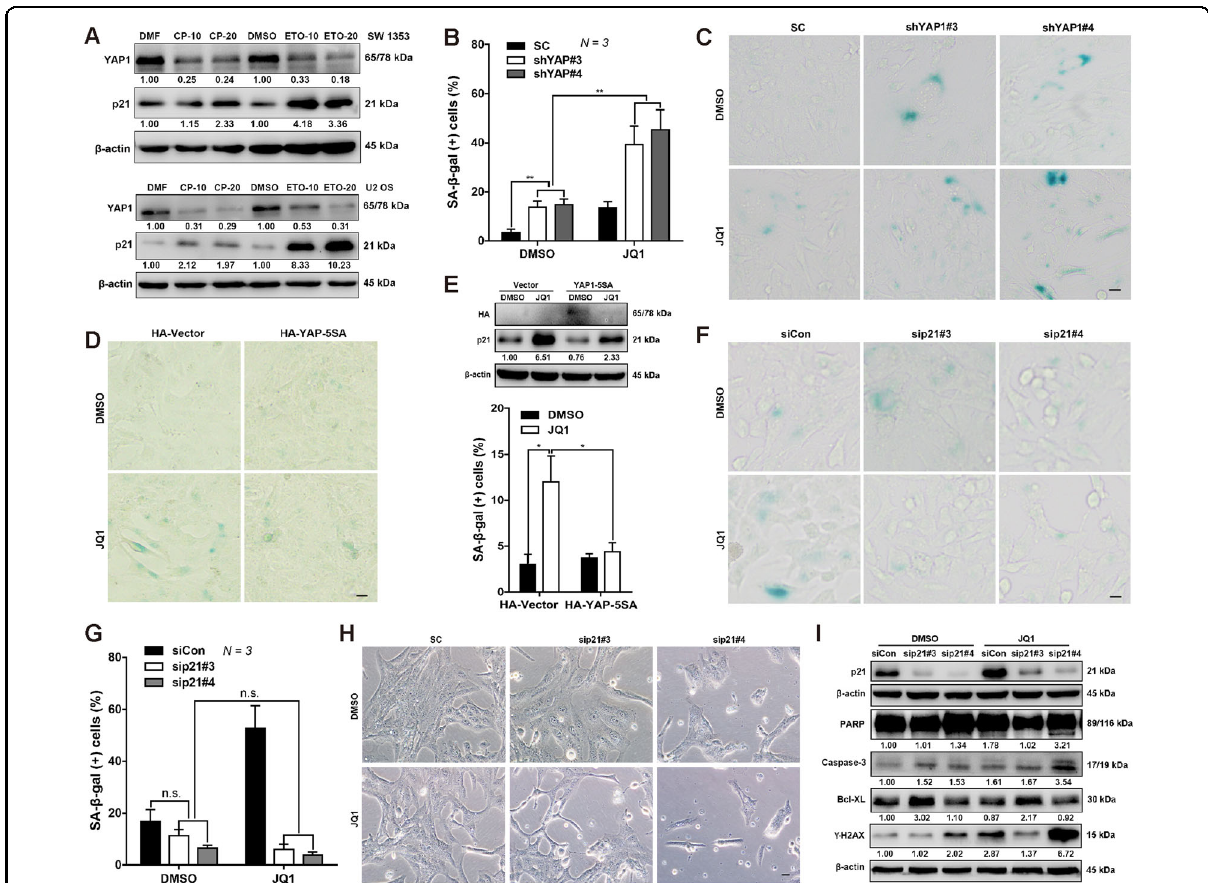
Fig. 6 The YAP1/p21 signaling axis is involved in chemotherapy-mediated cell senescence regulation. A SW 1353 and U2 OS cells were treated with dimethylformamide (DMF), cisplatin (CP; CP-10: 10 μ M, CP-20: 20 μ M), dimethyl sulfoxide (DMSO), and etoposide (ETO; ETO-10: 10 μ M, ETO-20: 20 μ M) for 24 h, and YAP and p21 expression was determined by IB. B , C YAP1 depletion enhances JQ1-induced senescence. Control shRNA or YAP1-depleted SW 1353 cells were treated with DMSO or JQ1 for 24 h, senescent cells were stained with SA- β -gal and quanti fi ed ( B ), and representative images are shown ( C ). Scale bars: 20 μ m. D , E YAP1 overexpression attenuates JQ1-induced senescence. SW 1353 cells were transfected with HA-Vector and HA-YAP-5SA, followed by treatment with DMSO or JQ1 for 24 h, and then the cells were stained with SA- β -gal ( D ), scale bars: 20 μ m. The SA- β -gal-positive cells were quanti fi ed ( E , below), and the expression of HA and p21 was con fi rmed by IB ( E , above). F , G Knockdown of p21 abolishes JQ1-induced senescence. SW 1353 cells were transfected with p21-speci fi c siRNAs (sip21#3, sp21#4), followed by DMSO or JQ1 for 24 h. Then, the cells were subjected to SA- β -gal staining ( F ), and the positive cells were quanti fi ed ( G ). H , I Knockdown of p21 transforms JQ1-induced cellular senescence into apoptosis. Cells were treated as in ( F ), and representative cell images are shown in ( H ). Knockdown ef fi ciency and apoptosis-related (PARP, Caspase-3, Bcl-XL) and DNA damage-related ( γ -H2AX) protein expression were detected by IB ( I ). Scale bars: 20 μ m. Data are presented as the mean ± SD of at least three independent experiments in ( B , E , G ). Two-way ANOVA followed by Tukey ’ s test for ( B , E , G ). n.s. nonsigni fi cant, * P < 0.05, ** P <